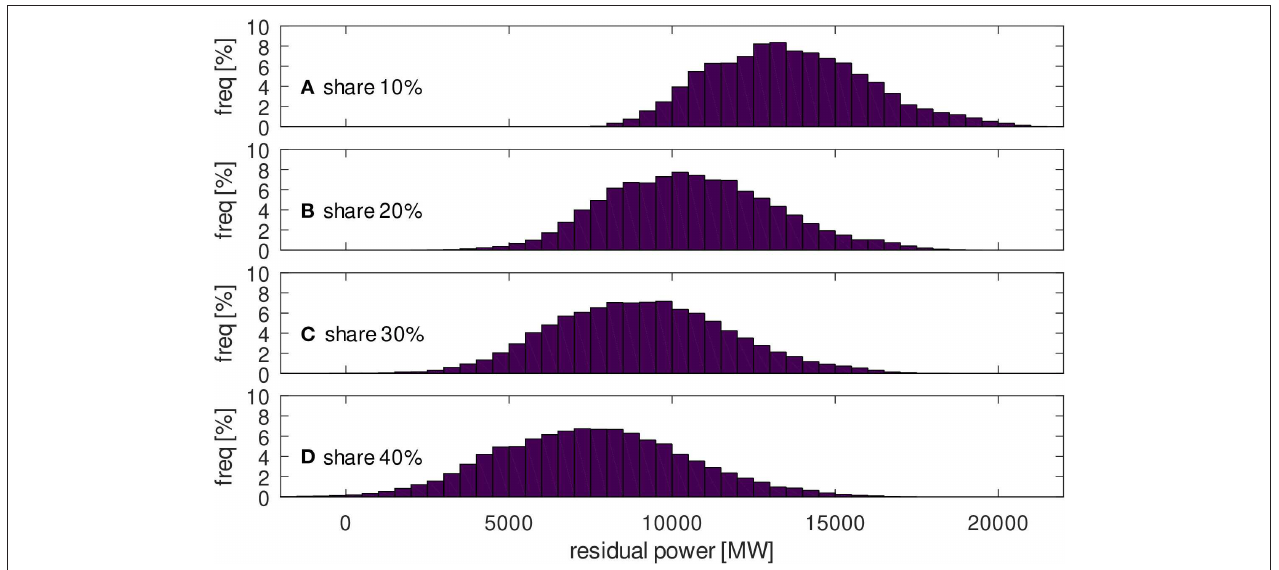
FIGURE 8 | Histograms of residual power for the 2015–2016 electricity load scenario. (A) Assuming current installed and projected capacity; (B) 20 % of renewables contribution to electricity load in energy terms; (C) 30 % ; (D) 40 % . Bin width is 500 MW.